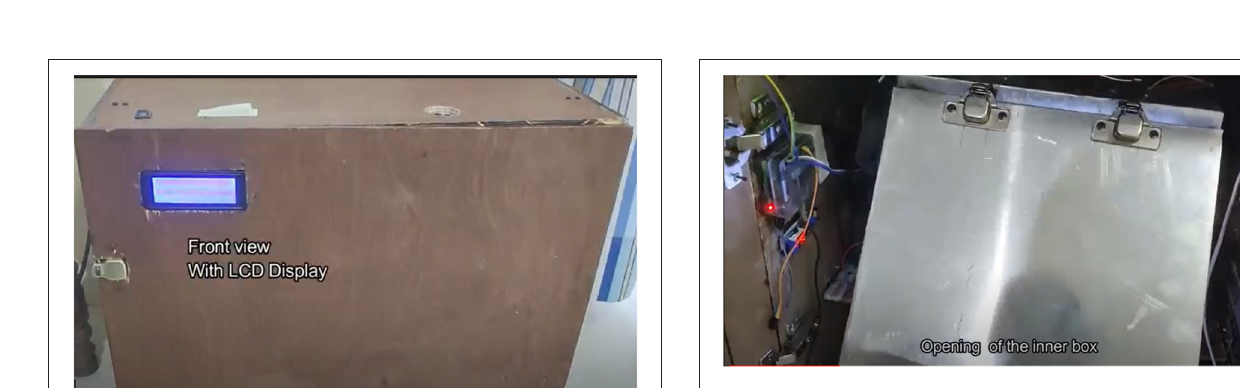
FIGURE 13 | Device internal